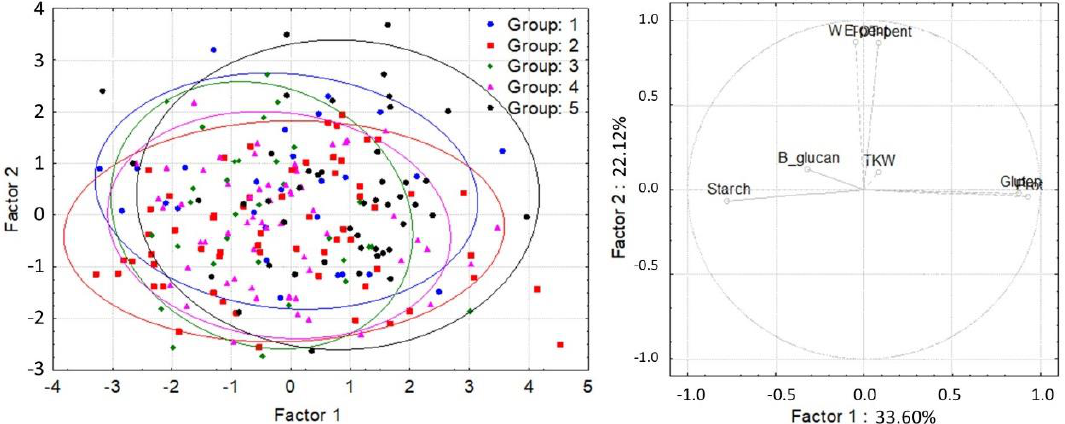
Figure 4. Principal component analysis based on the compositional quality traits of wheat and grouped by the groups formed by the hierarchical cluster analysis. B-glucan = β -glucan content, Gluten = gluten content, Prot = protein content, Starch = starch content, TKW = thousand-kernel weight, TOT-pent = total pentosan content, and WE-pent = water-extractable pentosan content (where the most determinant traits contributing to Factor 1 were Prot (0.9279), Gluten (0.8768), and Starch ( − 0.7757), while they were TOT-pent (0.8686) and WE-pent (0.8728) for Factor 2).